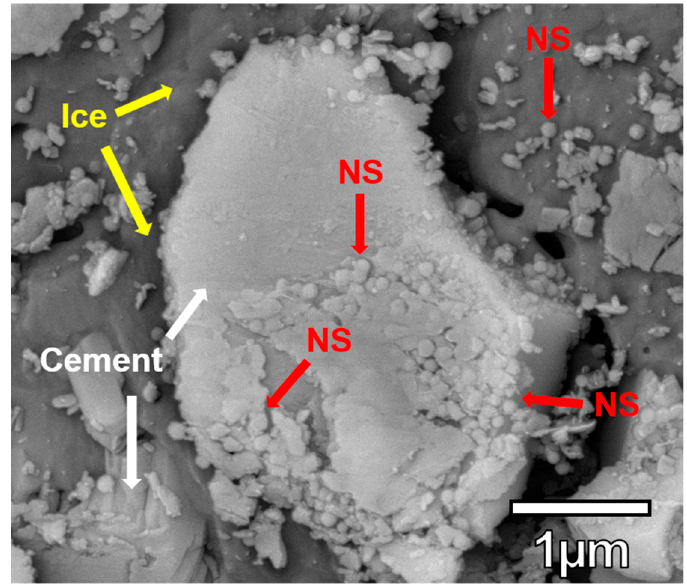
Figure 8. CryoSEM image showing unreacted NS on a cement grain